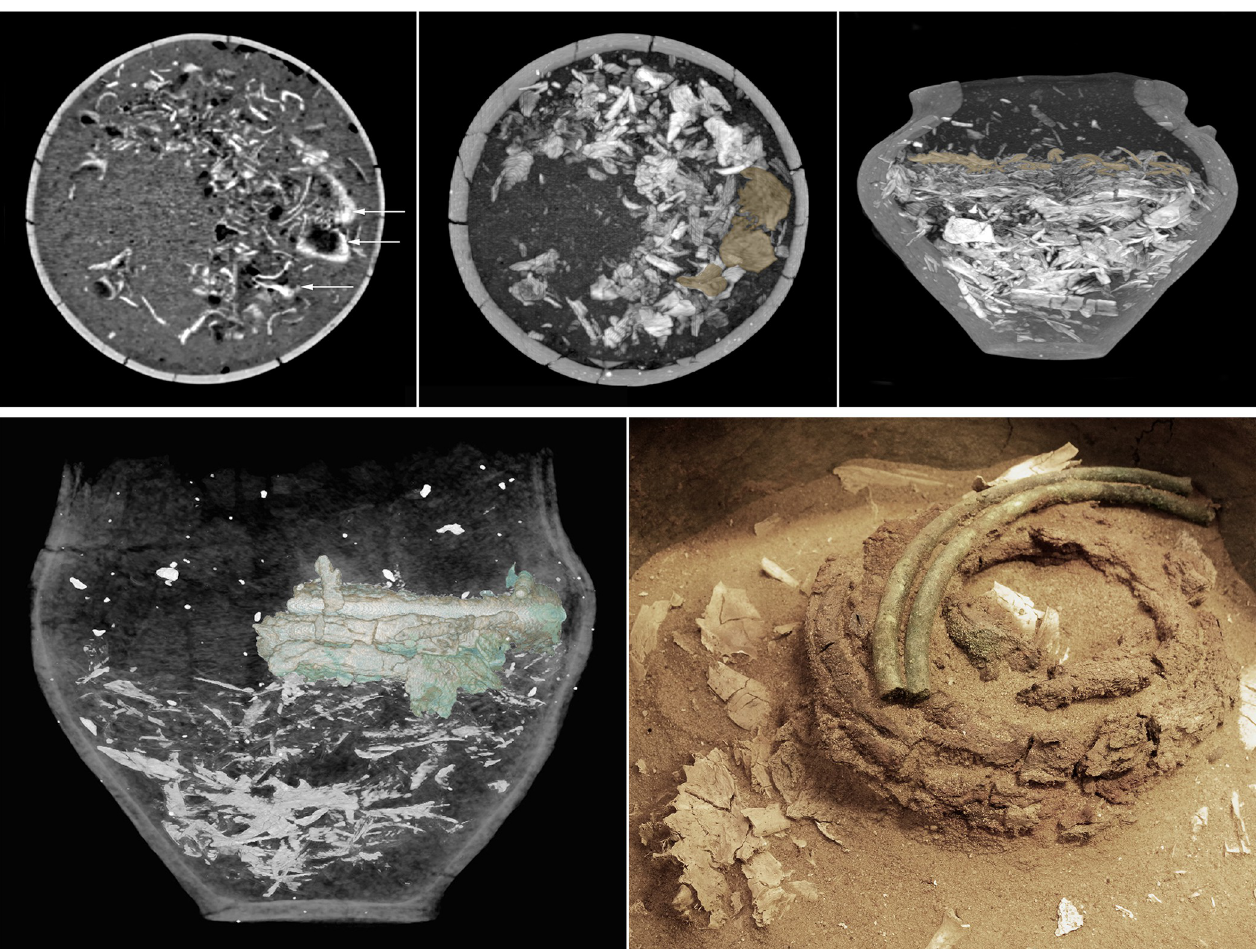
Fig 9. The results of CT imaging of the fills of the urn from graves 557 and 528. In the upper row, fragments of the skull vault bones are visible in the upper part of the fill of the urn from grave 557; the arrows and the brown colour mark the identifiable fragments of the parietal bones and the right zygomatic bone. In the lower row, the urn from grave 528 and the visualization of metal objects in MIP reconstruction and their actual appearance during the exploration.